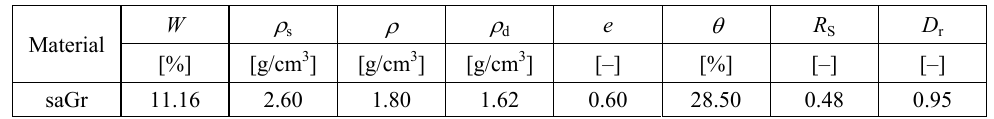
Table 1. Physical characteristics of the soil tested